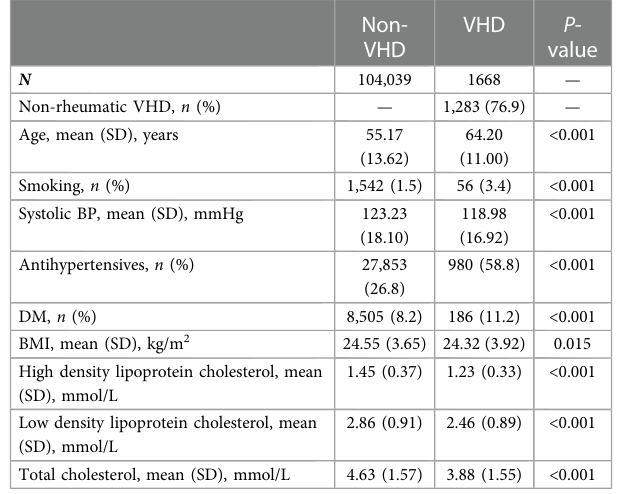
TABLE 1 Characteristics of study